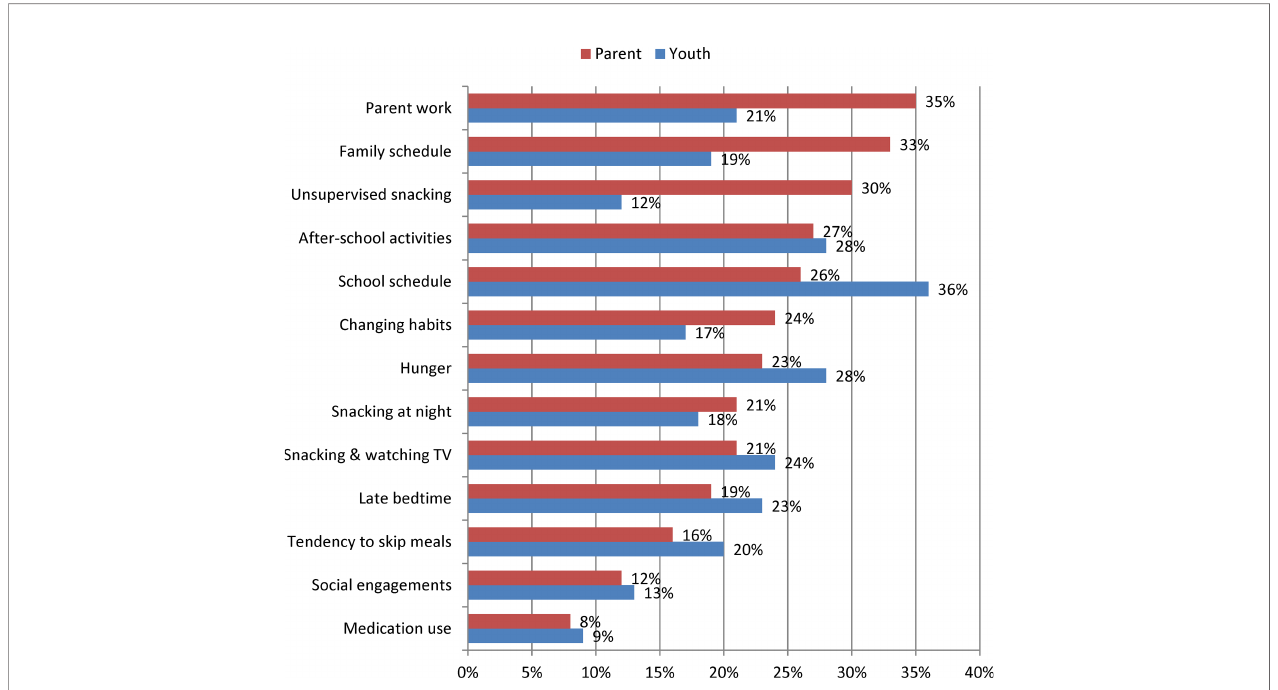
FIGURE 2 | Frequency of Perceived Barriers to Time-Limited Eating among Parents of Youth 8 to 17 years old (n = 213) and among Youth 11 to 17 years old (n = 159). Data were collected between January and November